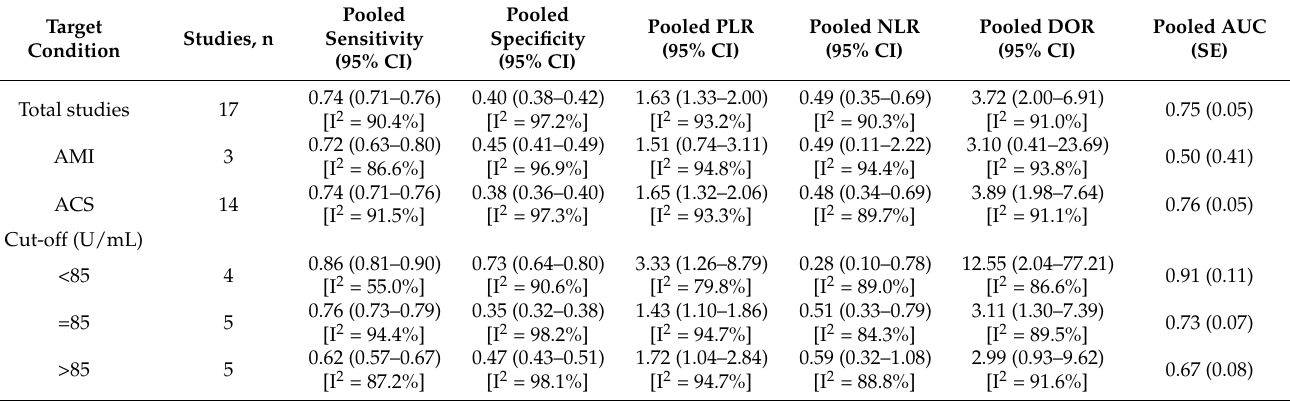
Table 2. Pooled estimates for diagnostic accuracy of serum IMA level for acute coronary syndrome.